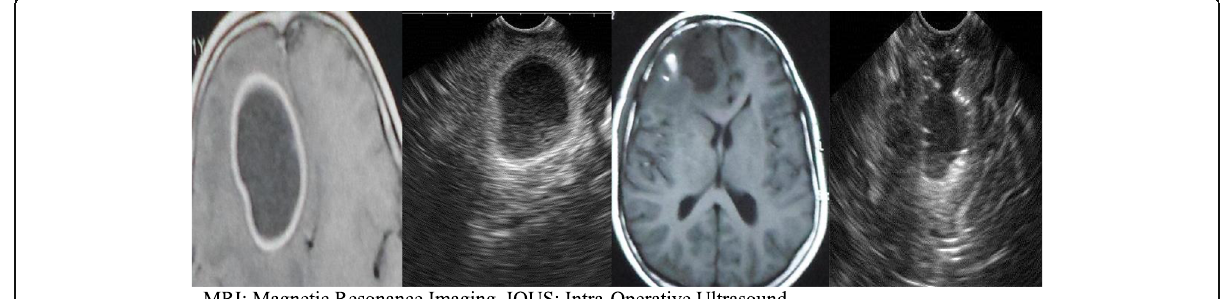
Fig. 10 Gross total resection of brain abscess; preoperative and postoperative MRI T1 with contrast and